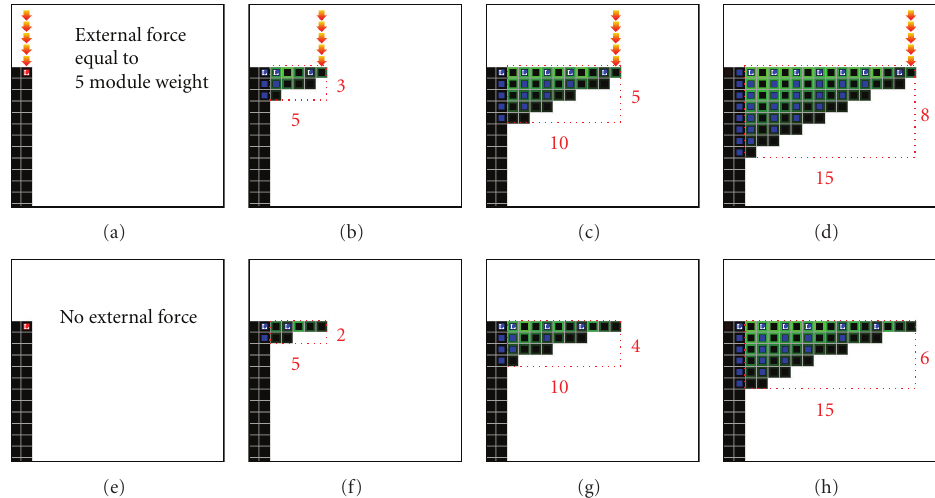
Figure 16: Di ff erence of cantilever shapes caused by external force ((a–d) Simulation result of adaptive cantilever construction on a load condition caused by external force and weight of modules themselves, (e–h) on a load condition caused by weight of modules themselves only).